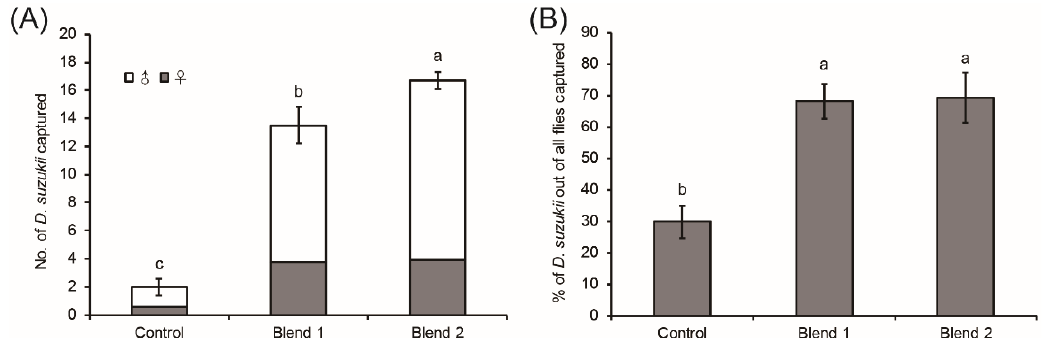
Figure 3. ( A ) Number (mean ± SE) of female and male Drosophila suzukii captured in traps ( N = 9). ( B) Percentage (mean ± SE) of D. suzukii captured out of all flies ( N = 9). Control: hexane; Blend: a mixture of 7-EAD-active compounds of 0.01 µ g/ µ L (Blend 1) and 0.1 µ g/ µ L (Blend 2) at the natural ratio (100 µ L). Different letters indicate significant differences among different treatments at the 0.05 level.